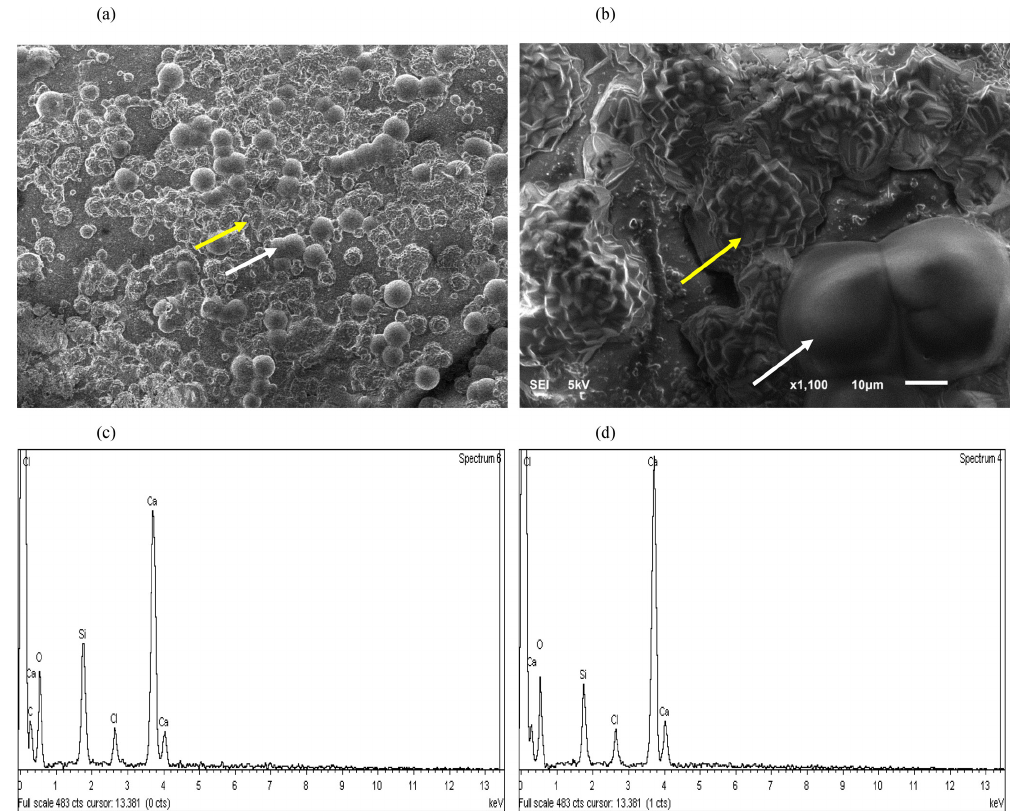
Figure 5. SEM image of the (a) whole surface (bar, 100µm) and (b) magnified (bar, 10µm) silica granule with crystalline (yellow arrow) and amorphous (white arrow) calcium structures following bacterial treatment. EDS analysis shows the chemical composition of (c) crystalline and (d) amorphous precipitates.